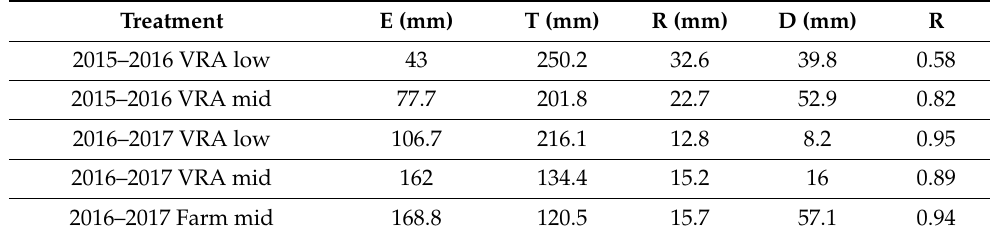
Table 5. Simulation results (E, evaporation; T, transpiration; R, runoff; D, drainage) and Pearson correlation coefficients between measured and simulated mean daily soil water content for each 1 m profile (n = 87).